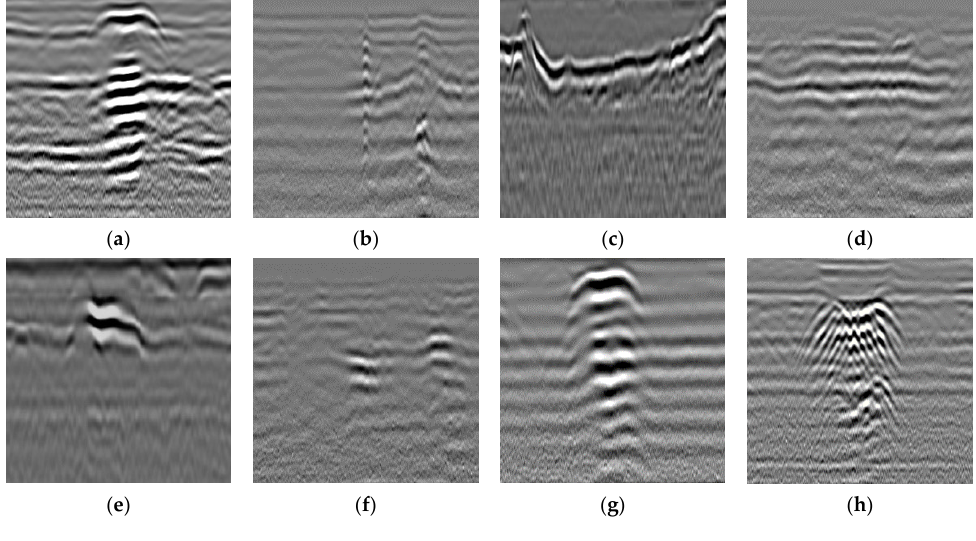
Figure 4. Partial GPR images 1 − 8 ( a − h ).